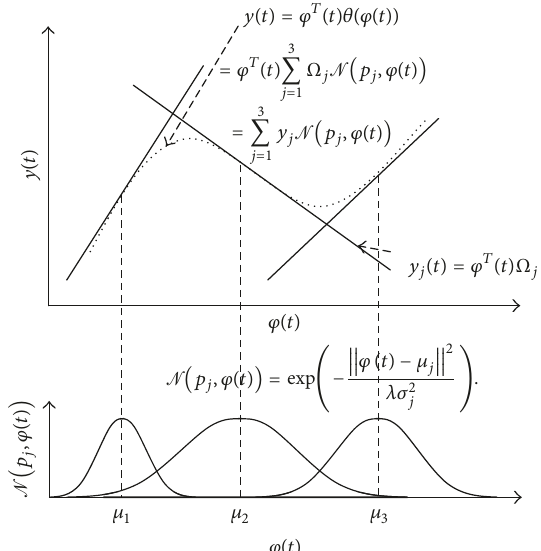
Figure 2: A local linear interpretation for the quasi-ARX RBFN model. A one-dimensional nonlinear system is approximated by three linear submodels, whose operating areas are decided by the associated RBFs; meanwhile, the RBFs also provide interpolations or weighs for all the linear submodels dependent on the operating points. A main interpolation is obtained from a linear submodel when the operating point is near to the center of the associated RBF, while only a minor one can be received when the operating point is far from the corresponding